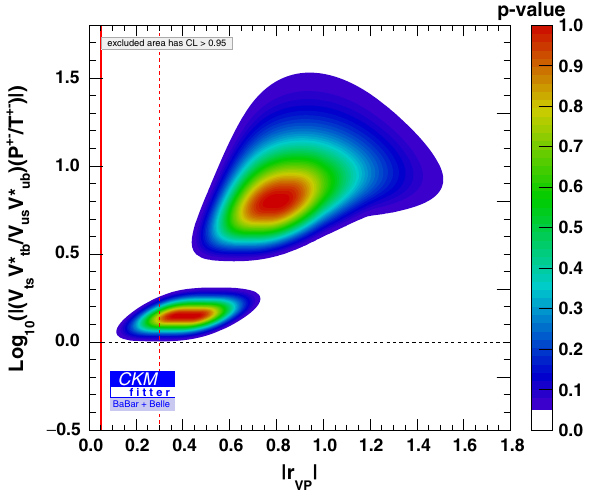
Fig. 8 Two-dimensional constraint on | r V P | defined in Eq. (27) and (cid:5) (cid:4) | P +− / T +− | Log 10 . The vertical solid ( dashed ) red line corresponds to the CPS/GPSZ prediction, with a 5% (30%) uncertainty